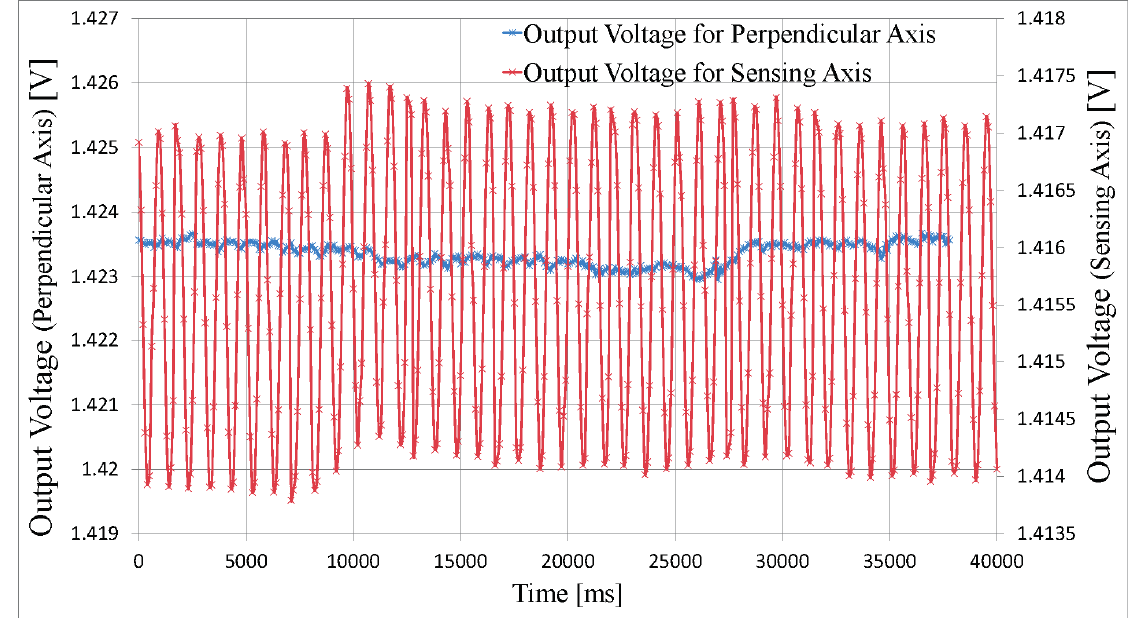
Figure 10. Measured sensor output voltage for angular motion stimuli on the sensing axis and for angular motion stimuli on the cross-axis (the sensor is subjected to the same modulated angular rate of ±3 °/s for both, in-plane and perpendicular